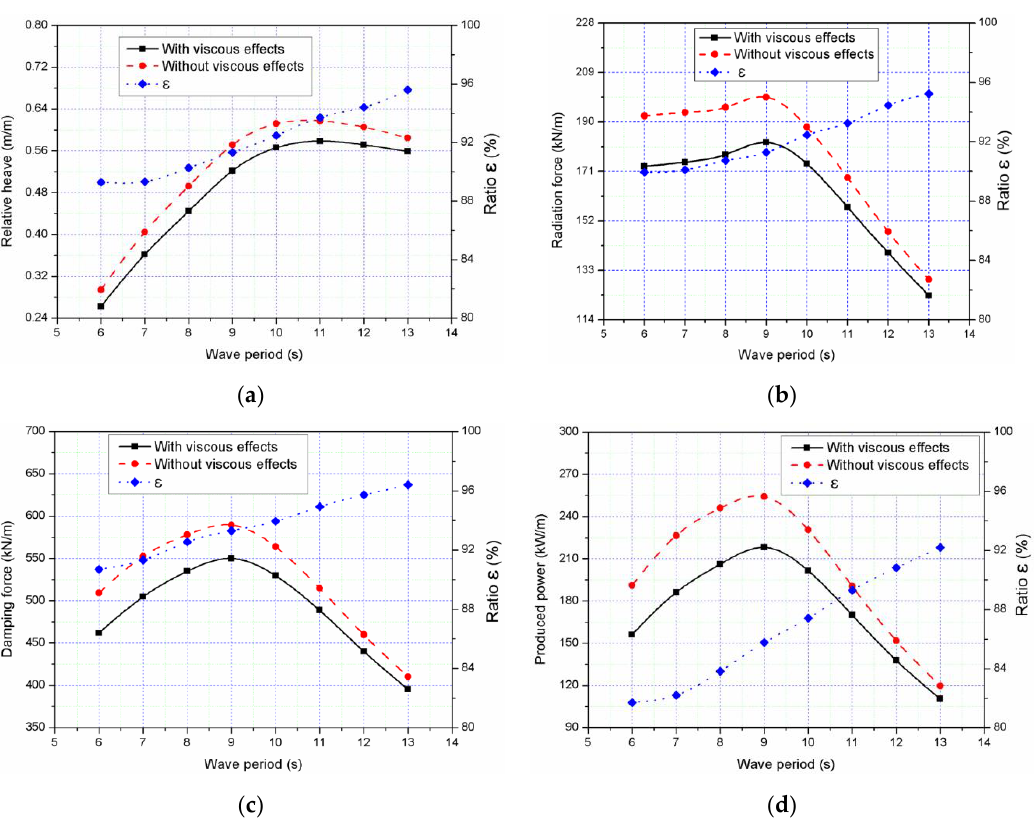
Figure 7. Comparison of responses of the WEC with and without viscous effects: ( a ) relative heave; ( b ) radiation force; ( c ) damping force; ( d ) produced power.